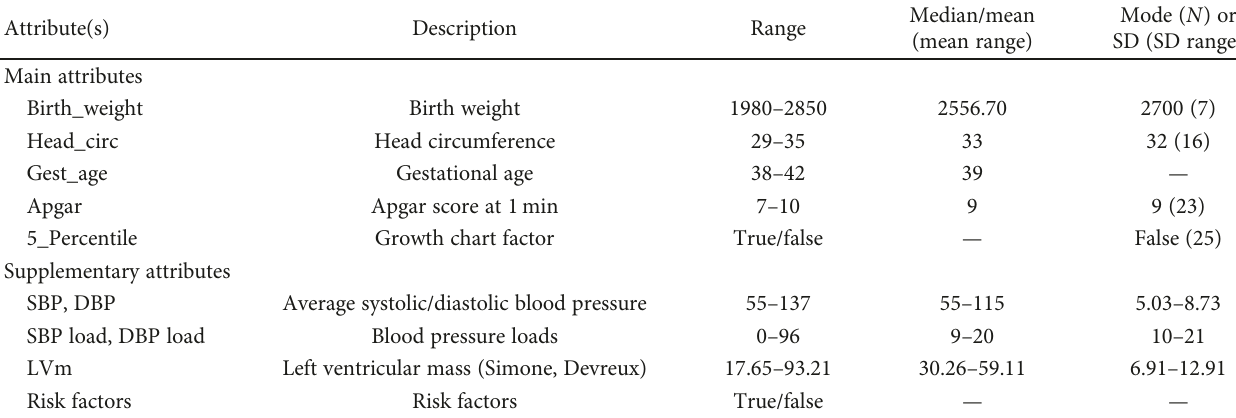
Table 3: Characteristics of attributes for the “ IUGR ”